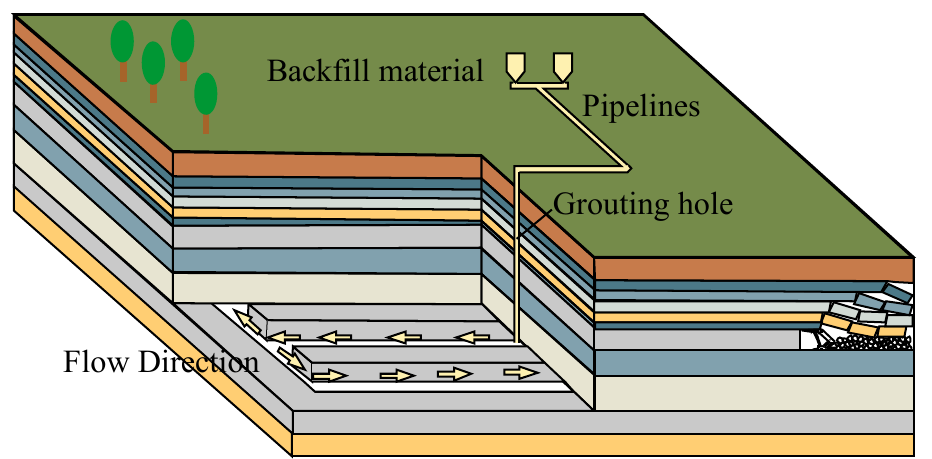
Figure 2. Sketch map of goaf backfilling.